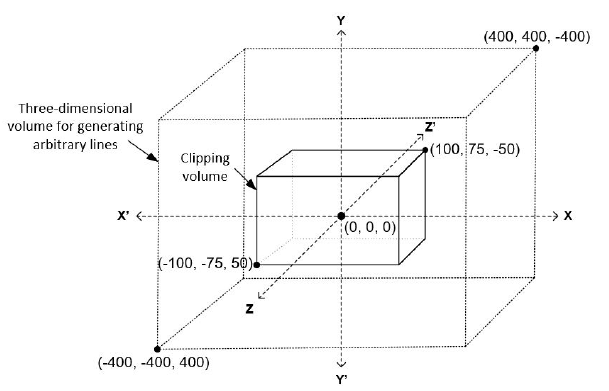
Figure 17. The three-dimensional space used for generating arbitrary lines and setting the clip- ping volume.